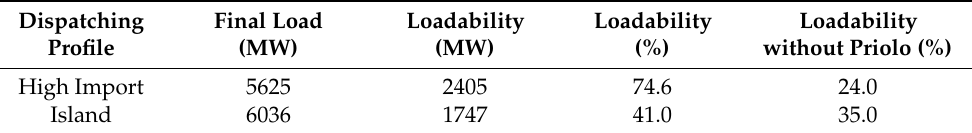
Table 23. Loadability margins for the selected DPs for 2050 with a full RES reactive contribution of Priolo as wind